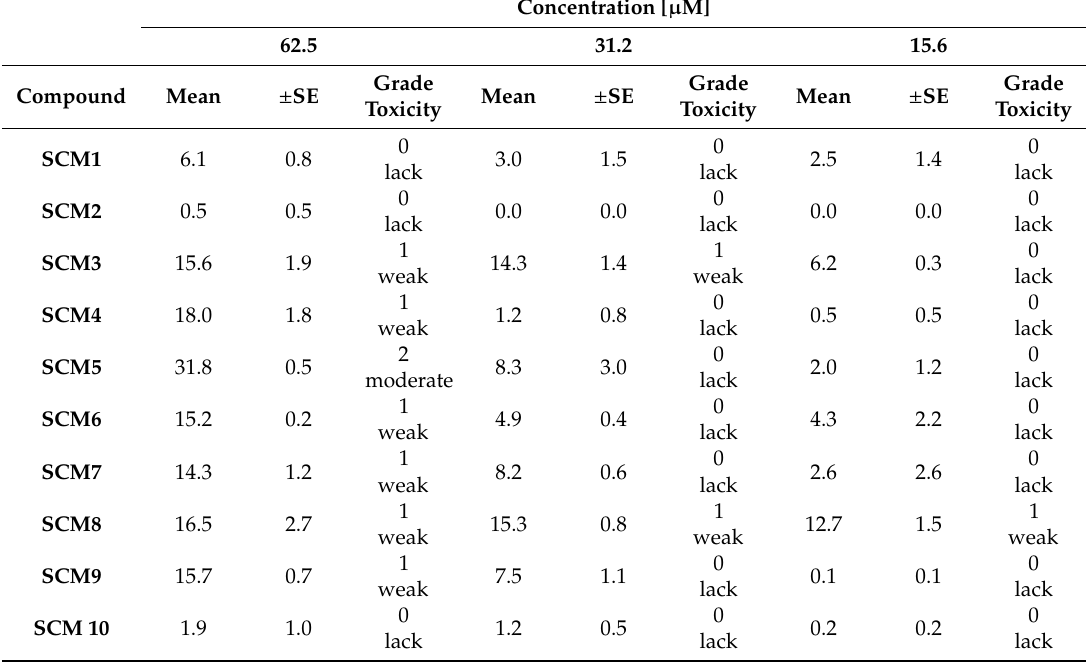
Table 1. The cytotoxic e ff ect of SCM compounds on A-549 cell line. The cells were treated with di ff erent concentrations (62.5, 31.2 and 15.6 µ M) of SCM compounds for 72 h. The raw results, which were obtained as OD (Optical Density) values from quadruplicate wells, were then transformed into the final results that are presented as % of dead cells (mean values ± SE) in relation with appropriate DMSO controls. The level of toxicity was defined according to the requirements presented in EN ISO 10993-5:2009(see Table